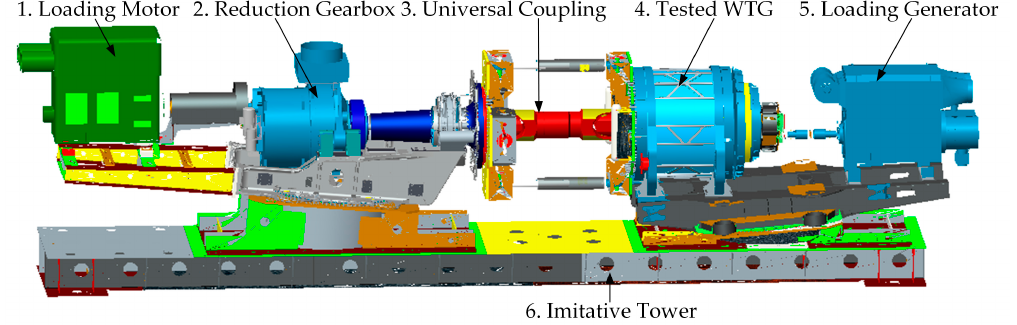
Figure 5. 3D model of the entire test rig.